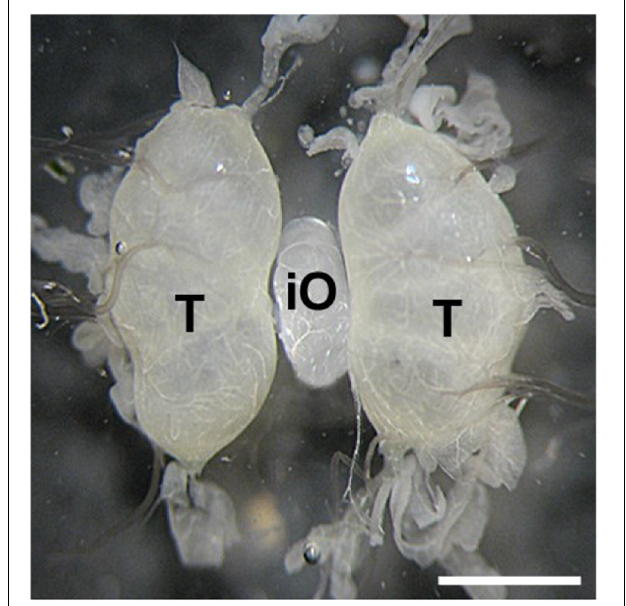
FIGURE 1 | An examples of ovary implantation. Implanted PK1 ovaries (iO) positioned between the endogenous testes of the K23 recipient (T). Scale bar: 500 µ